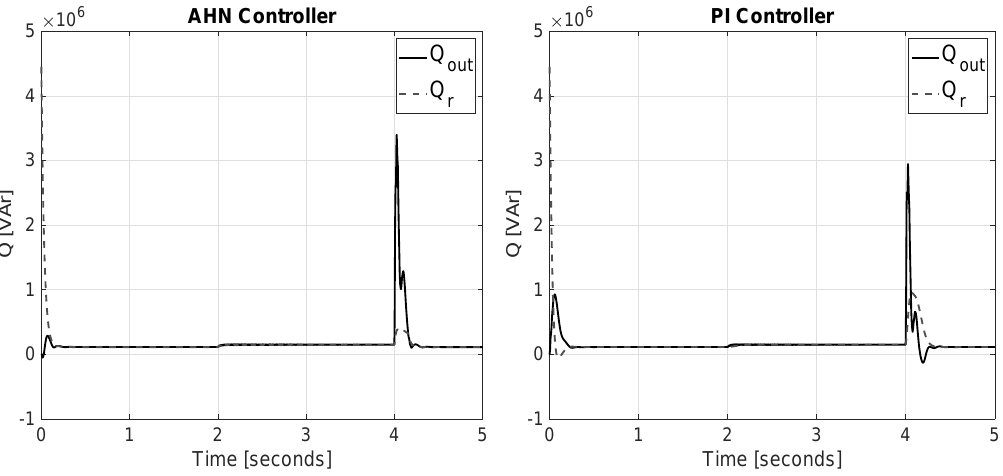
Figure 17. Simulation of reactive power regulation: Test 3.